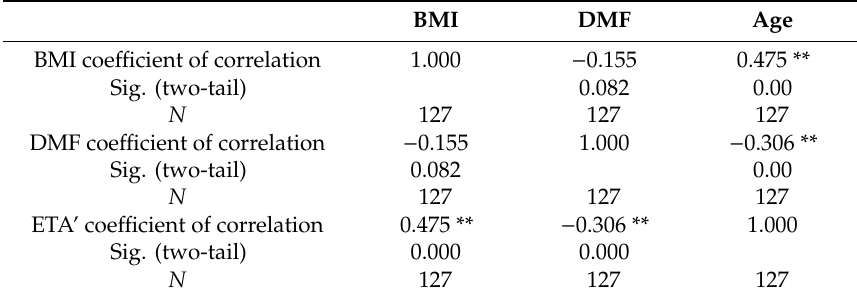
Table 18. Data related to the correlation between BMI, DMF and age for the whole sample. BMI DMF Age